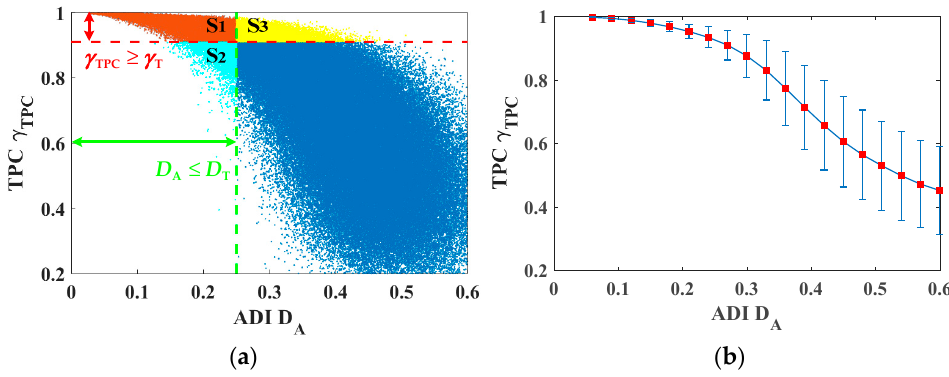
Figure 3. Numerical simulation results. ( a ) Scatter map of the TPC γ TPC with the ADI D A ; ( b ) variation curves of γ TPC with D A .